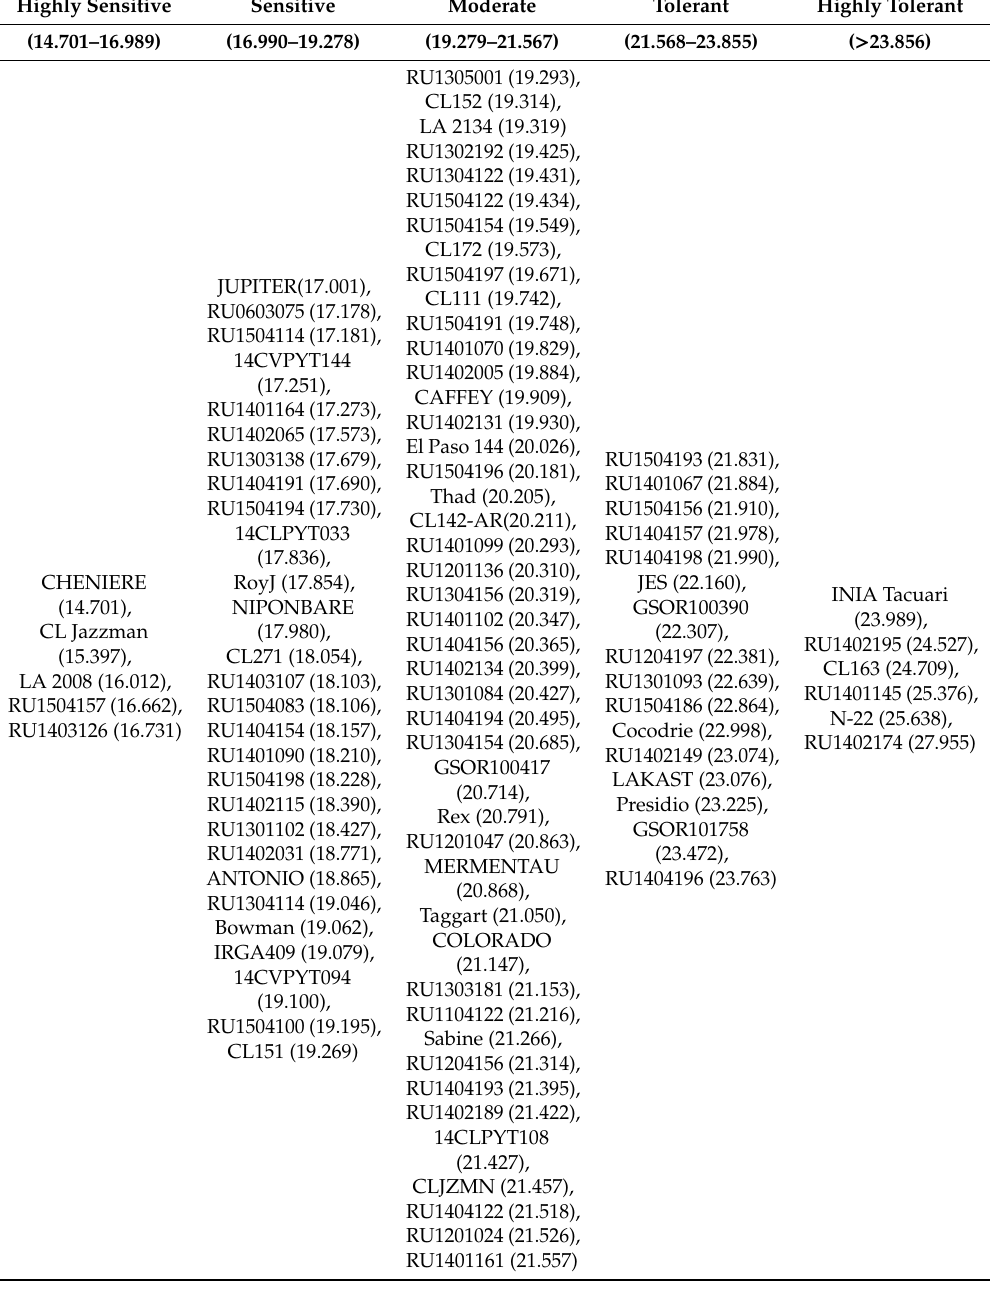
Table 2. Classification of rice genotypes into five drought response groups based on the cumulative drought stress response index (CDSRI), along with individual scores in